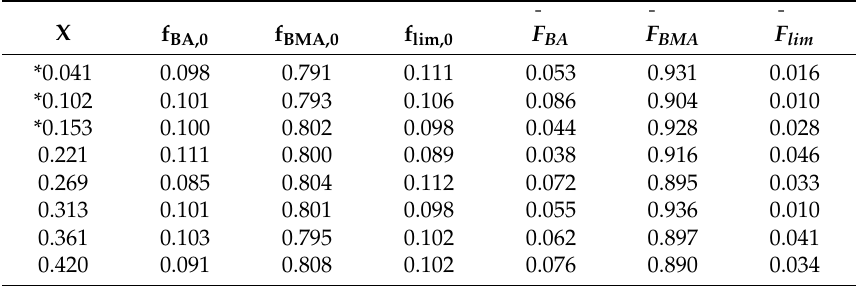
Table A1. Simulated data for the BA / BMA / lim terpolymerization (supplementing experimental data from Ren et al. [27]; see Section